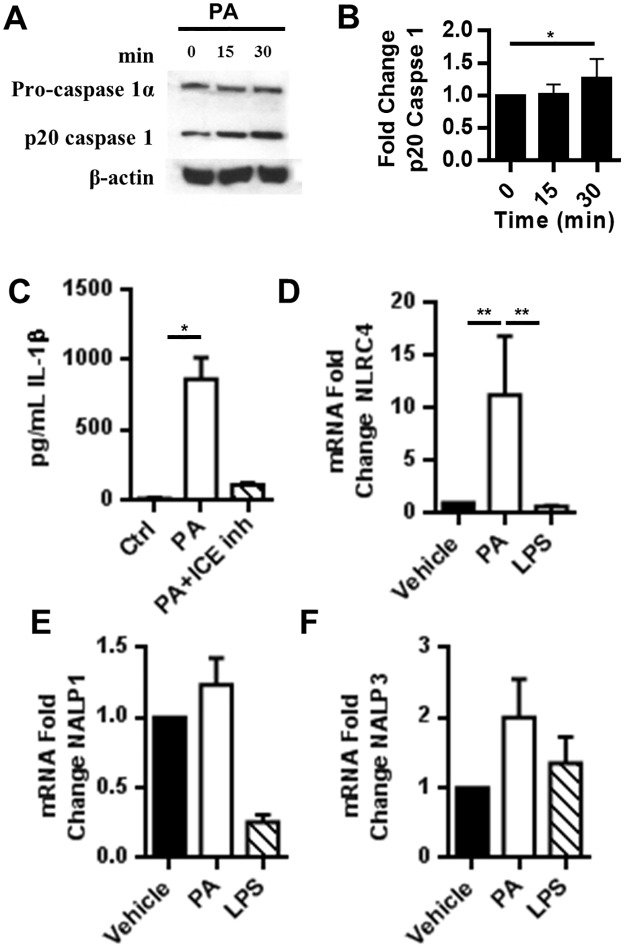
IL-1β is processed via caspase 1.(A-B) PA induces activation of caspase-1. MoDCs were treated with 300μM PA for the indicated times. The MoDC lysates were analyzed by western blot. (B) Bar graph is the average of 3 experiments and normalized to β-actin. (C) PA secretion of IL-1β is caspase-1 dependent. The supernatant from MoDCs treated with 300μM PA for 24hrs was analyzed by cytometric bead array. (D-F) PA induces inflammasome gene expression. MoDCs were incubated with 300μM PA for 6hrs and NLRC4, NALP1, and NALP3mRNA was analyzed by qRT-PCR.